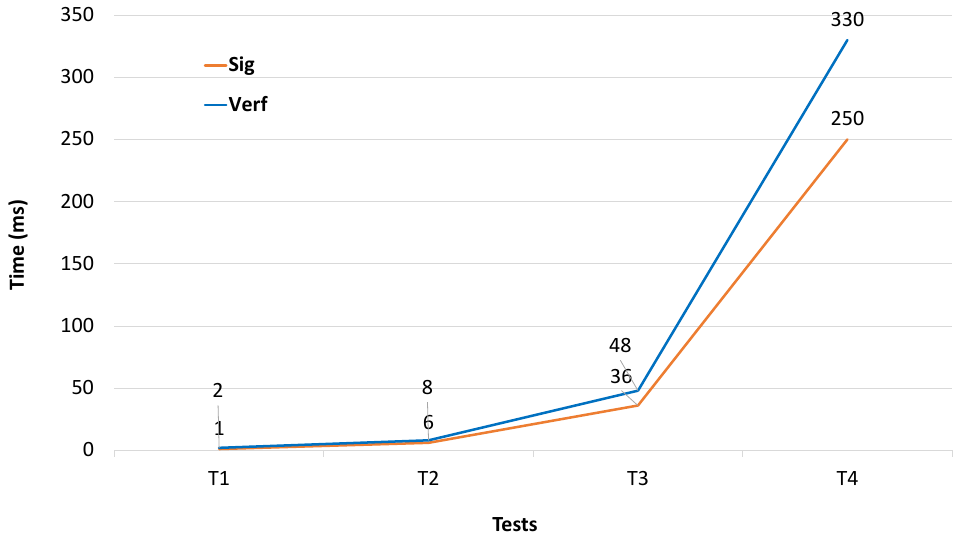
Figure 2. Signing and verifying execution time in the proposed